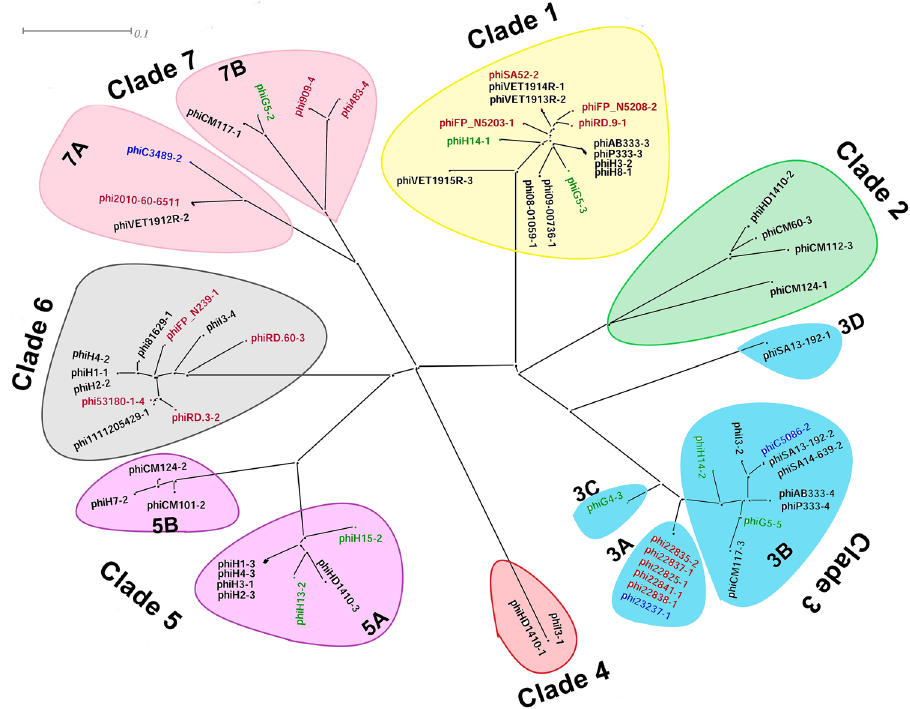
Figure 1. Cluster generated from the prophage genome sequences and phylogenetic relationship. The clades were shaded with different colors and the prophage names labeled in black, red, and blue colors represent the prophages extracted from the S. aureus associated with Homo sapiens , Bos tourus , and Canis lupus familiaris , respectively. And the prophage names labeled in green color represent the prophages extracted from our previous study 25,27